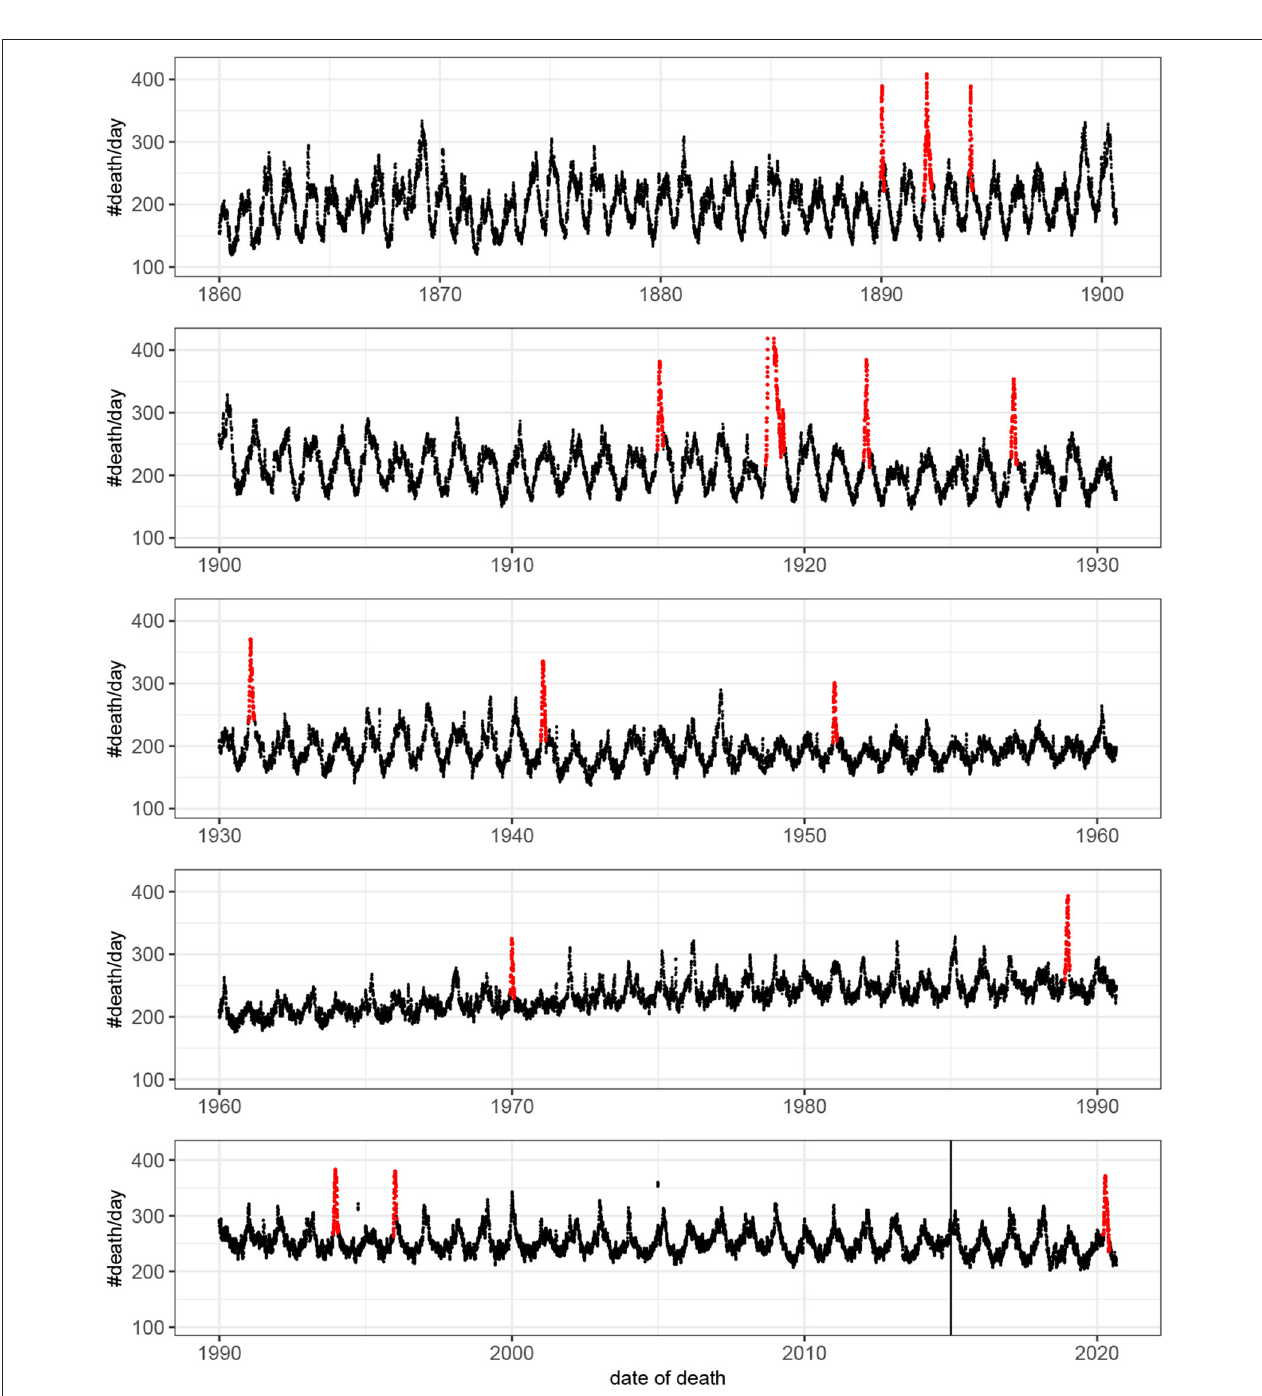
FIGURE 1 | Number of deaths per day as a function of time. For visualization the original count data have been smoothed by rectangular window of length seven. That is, each value represent the mean value of the neighboring seven values. Detected outbreaks are shown in red. Note that the peak of the outbreak of 1918–1919 has been truncated. The vertical line indicates the time point at which there was a change in data source (see